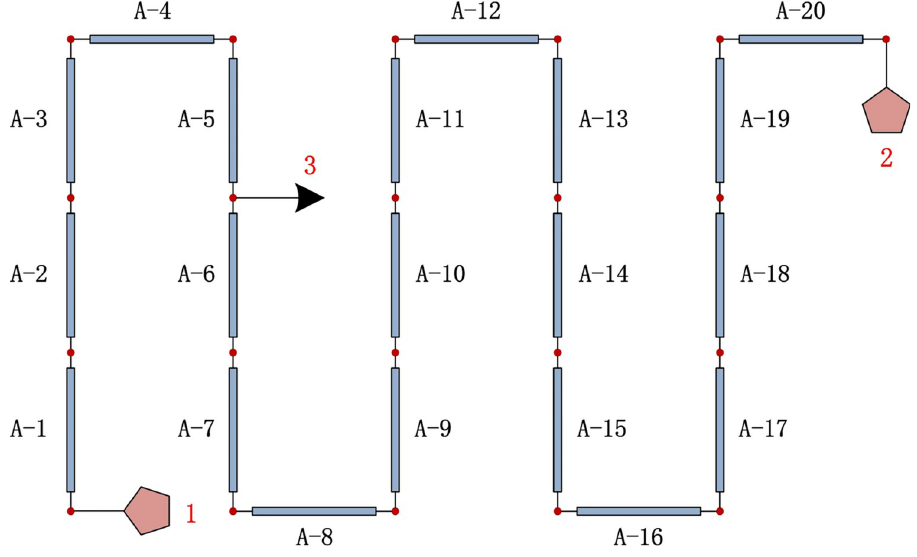
Fig 1. Pipe network